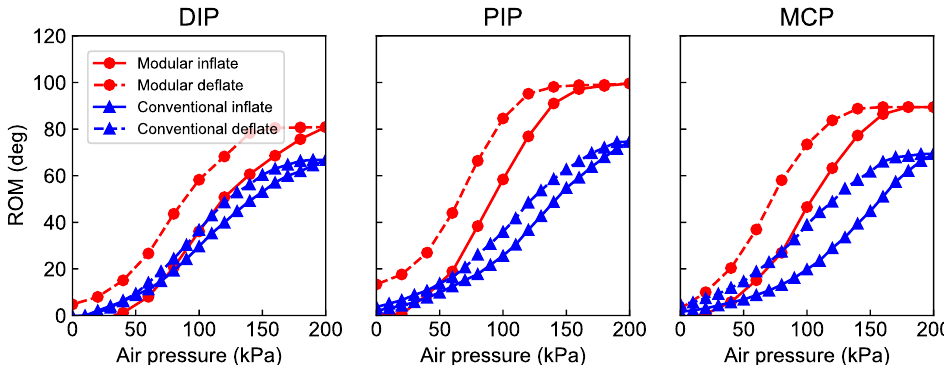
Figure 9. Joint ROMs when modular and conventional soft actuators were mounted to medium size dummy finger.